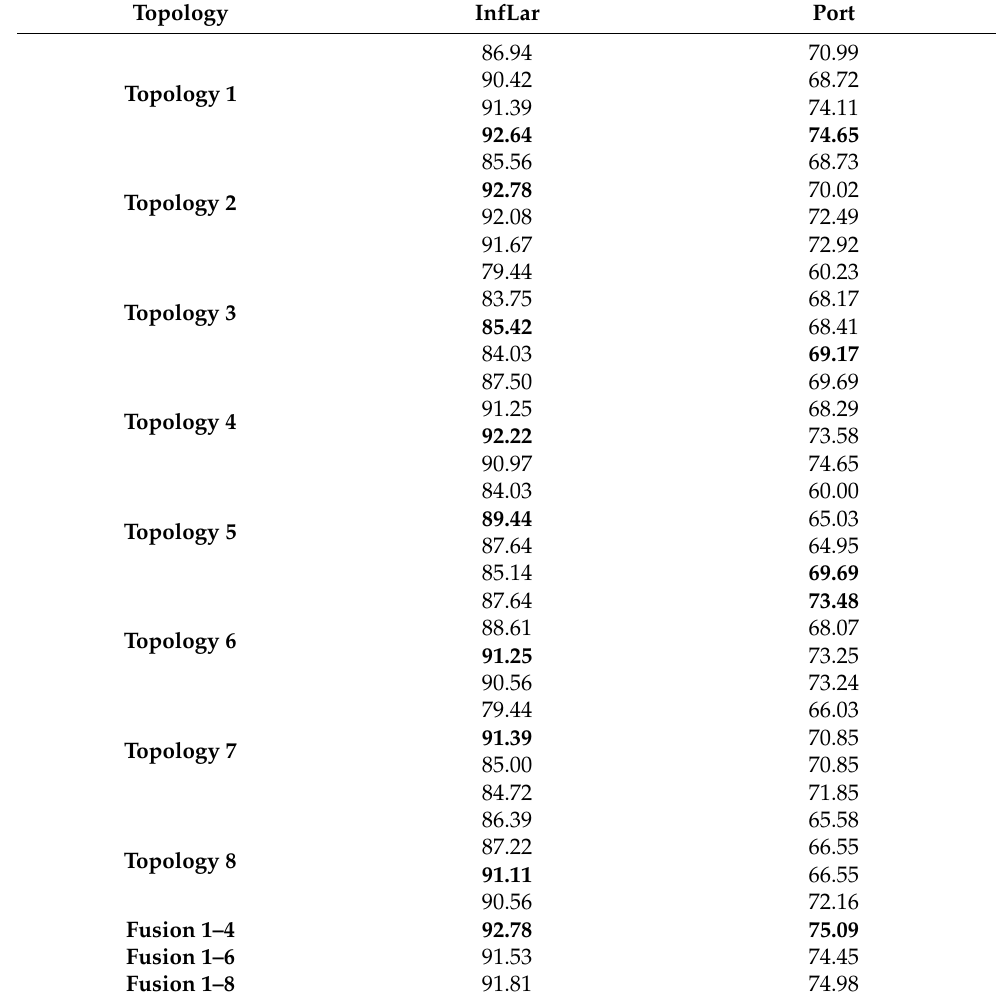
Table 2. Performance varying the network topologies (topologies are described in [14] and reprinted in the Appendix A; boldface represents the best performance).